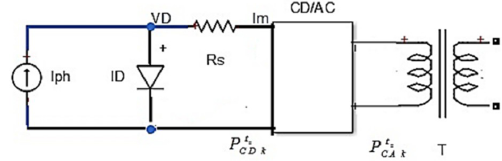
Figure 4. Schematic model of a photovoltaic module.